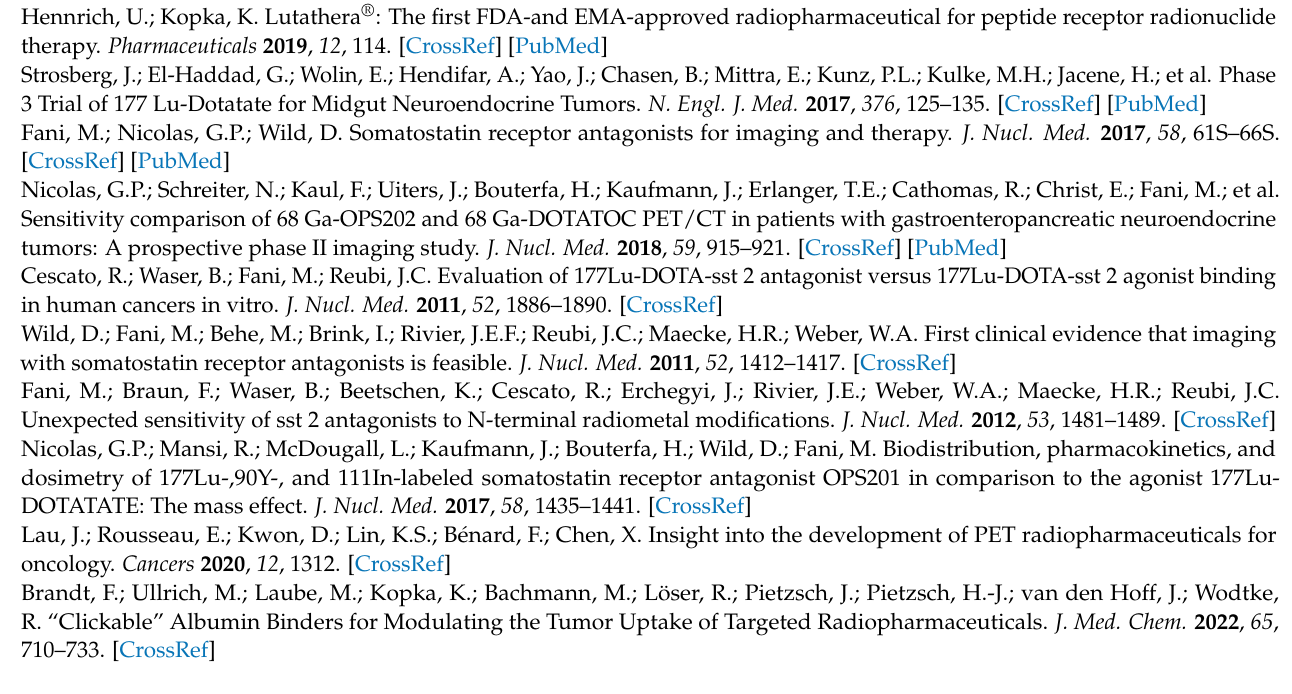
Figure S3: Radio-HPLC chromatograms of (A) [ 177 Lu]Lu- 8a and (B) [ 177 Lu]Lu- 8b ; Figure S4: Radio- HPLC chromatograms of the stability studies performed for [ 177 Lu]Lu- 8a at 1, 4, and 24 h post- incubation at 37 ◦ C of the radioligand in (A) PBS and (B) mouse serum; Figure S5: Radio-HPLC chromatograms of the stability studies performed for [ 177 Lu]Lu- 8b at 1, 4, and 24 h post incubation at 37 ◦ C of the radioligand in (A) PBS and (B) mouse serum; Figure S6: IC 50 curves of the in vitro competitive binding assays for compounds 8a and 8b in increasing concentrations (M) with [ 177 Lu]Lu- JR11 as radioligand; Table S1: Ex vivo biodistribution analysis of [ 177 Lu]Lu- 8a (5 MBq/0.5 nmol) at 4, 24, 48, and 72 h post-injection ( n = 4 mice/group). Data are represented as percentage of injected dose per gram of tissue (% ID/g); Table S2: Ex vivo biodistribution analysis of [ 177 Lu]Lu-JR11 (5 MBq/0.5 nmol) at 4, 24, 48, and 72 h post-injection ( n = 4 mice/group). Data are represented as percentage of injected dose per gram of tissue (%